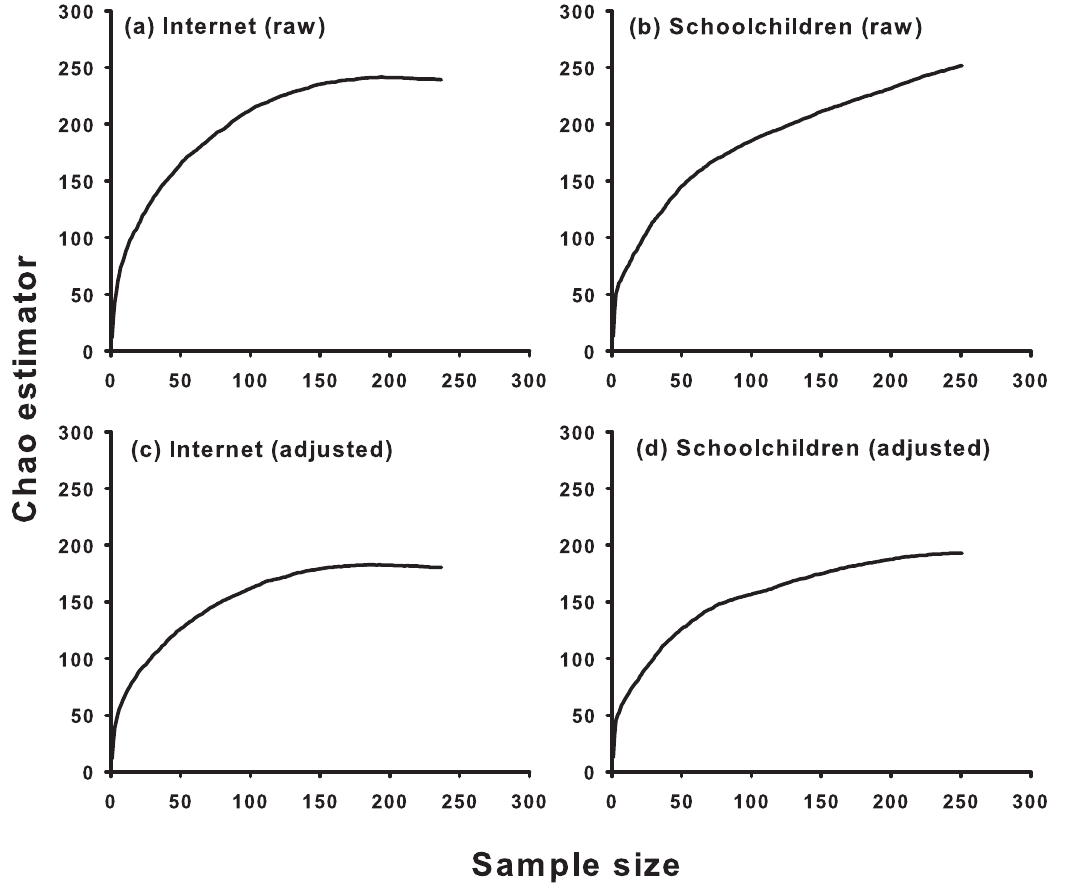
Figure 1. Sampling of ‘‘priority protection species’’. The adequacy of sampling was based on richness estimator (Chao estimator) for the internet (raw and adjusted, N=236 samples; see text for details) and schoolchildren (raw and adjusted, N=250 samples; see text for details). All the curves reached a plateau, indicating that we adequately sampled the diversity of ‘‘priority protection species’’ both for the internet and for schoolchildren.